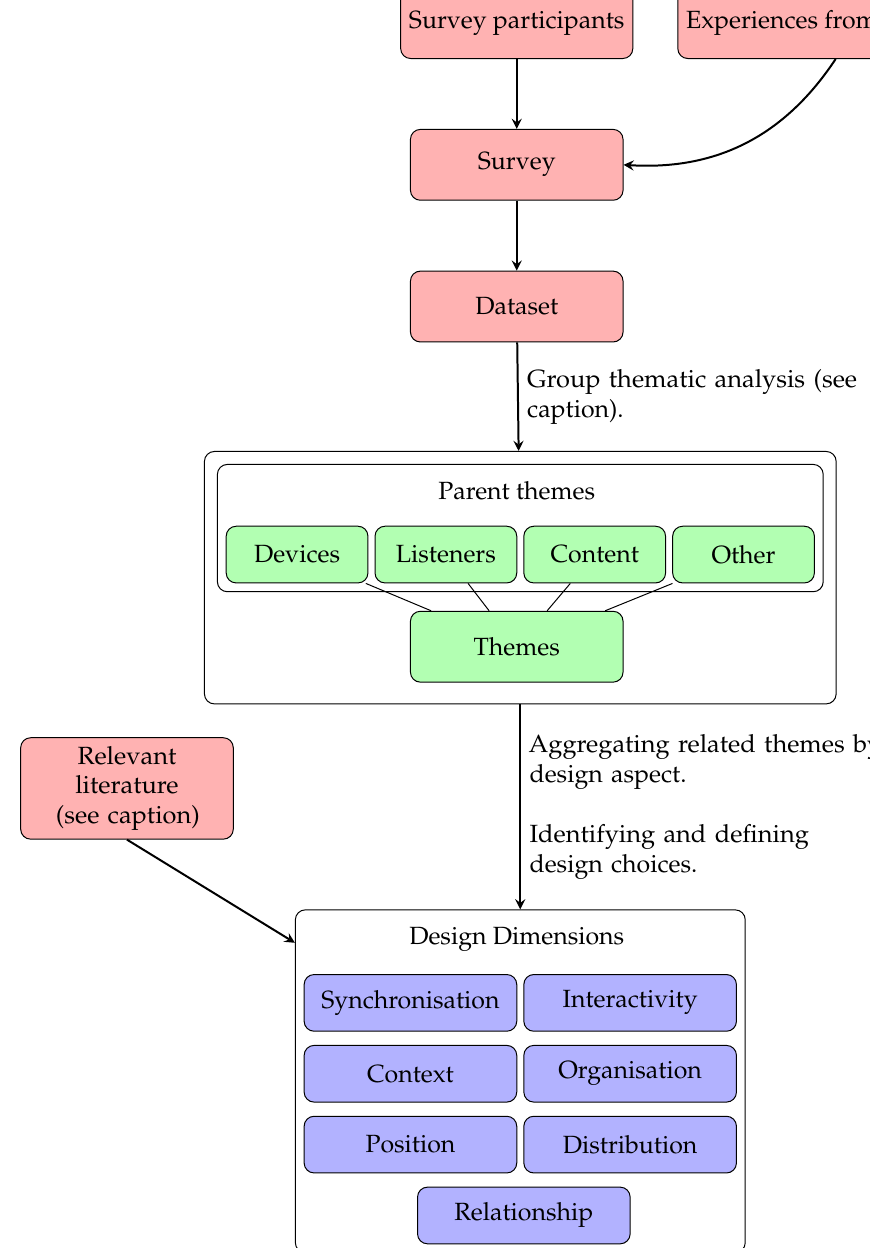
Figure 2. Diagram illustrating the methodology of obtaining the design dimensions from the original data. The thematic analysis followed Braun and Clarke’s methods [31]. The relevant literature [3,7,34] was considered when forming the design